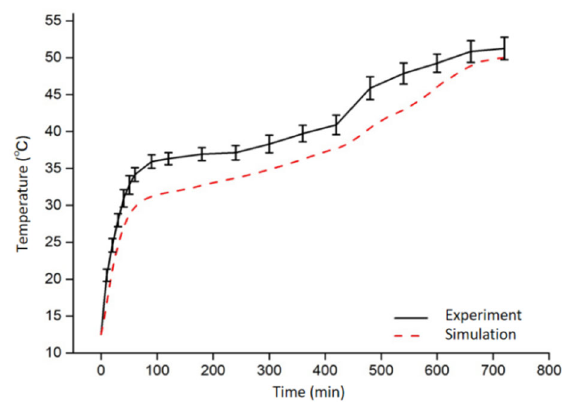
Figure 6. Time–temperature curve of the center point of potato during RF drying from both experi- ment and simulation.